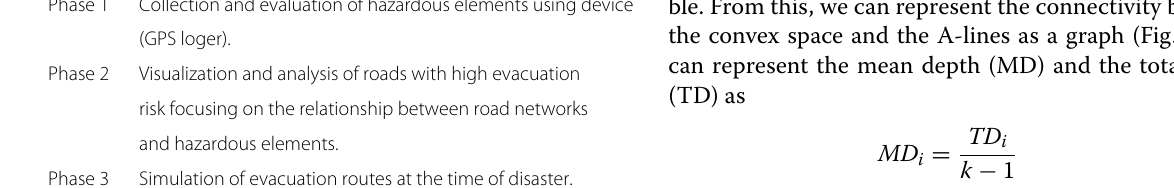
Table 1 Process of making disaster prevention map Phase 1